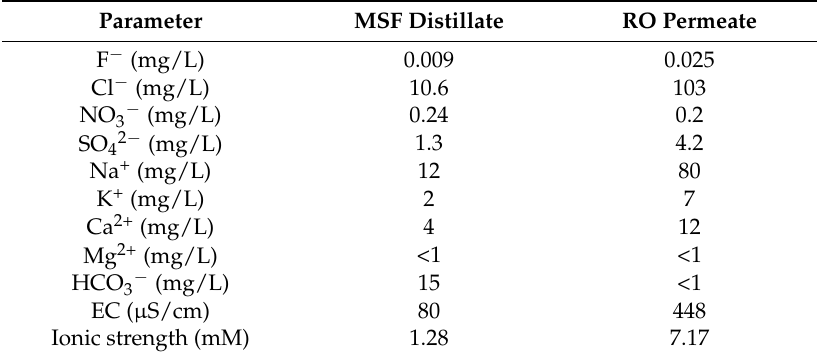
Table 1. Chemical characteristics of the MSF distillate and RO permeate. Parameter